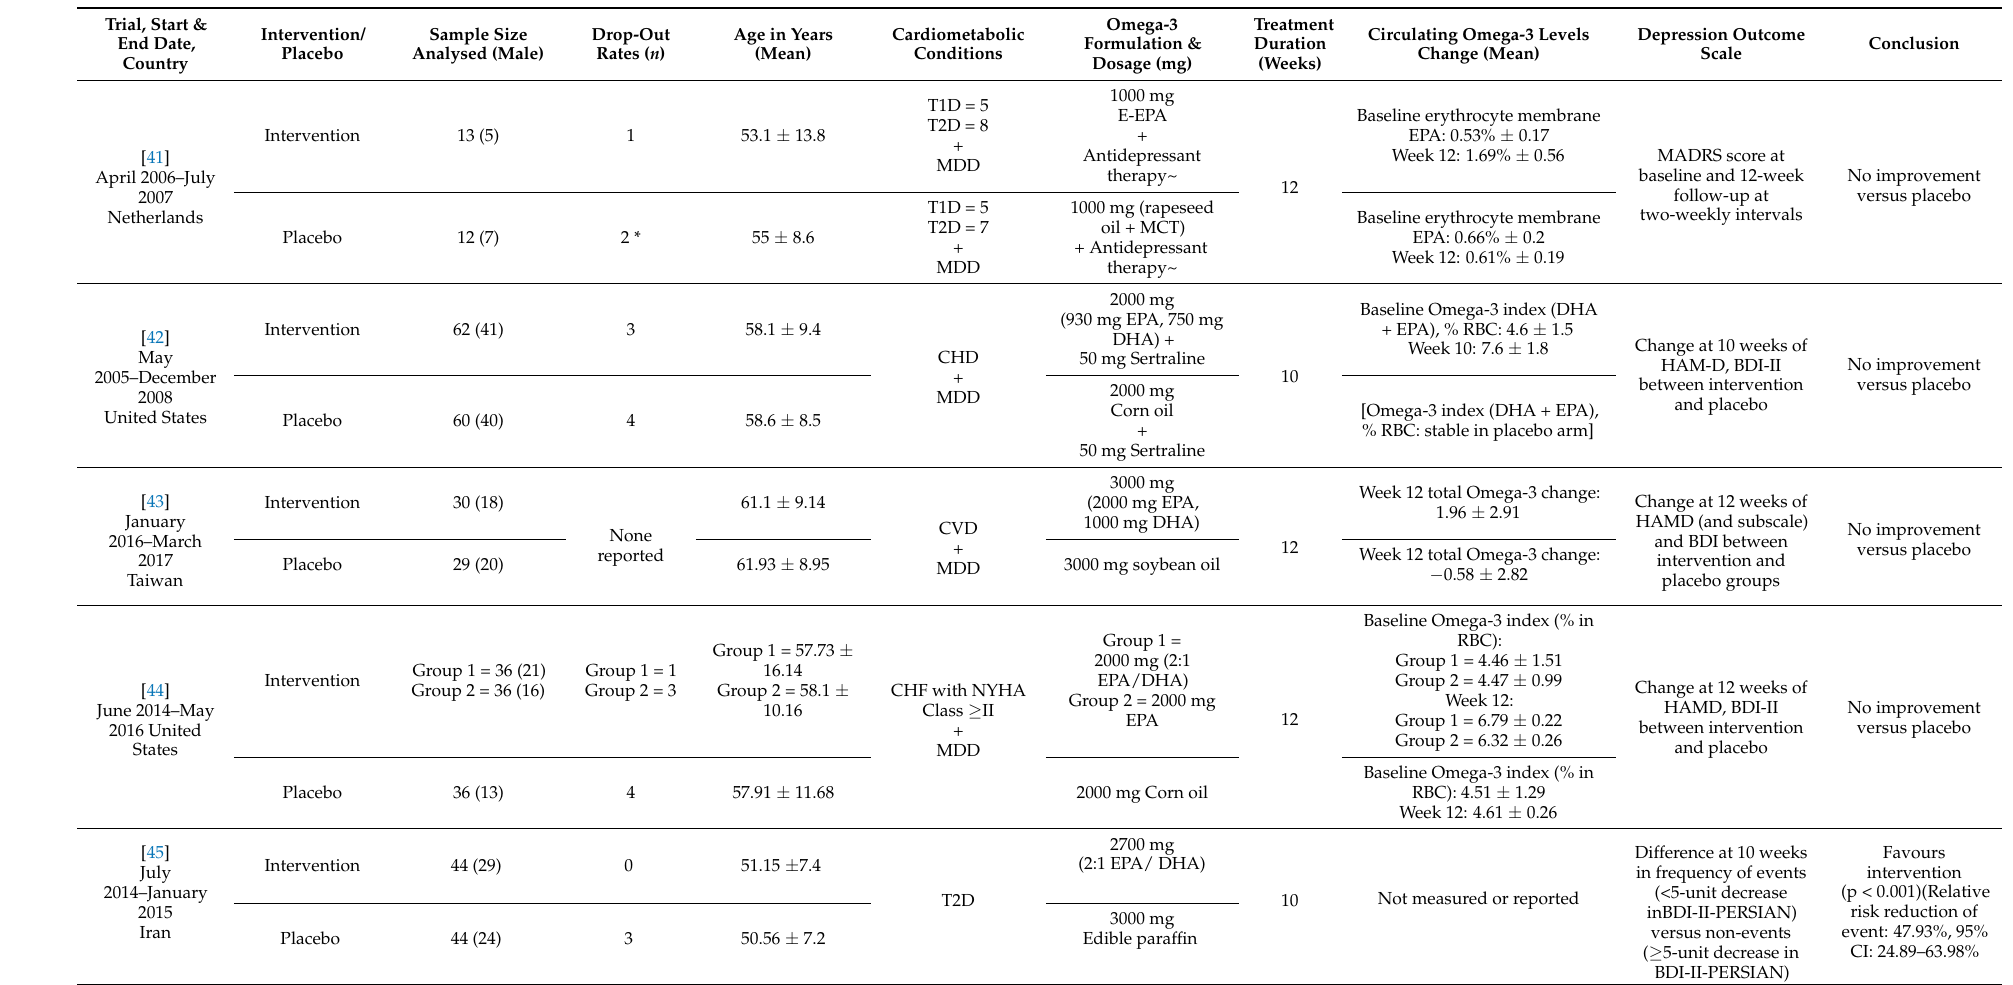
Table 1. Characteristics and outcomes of included